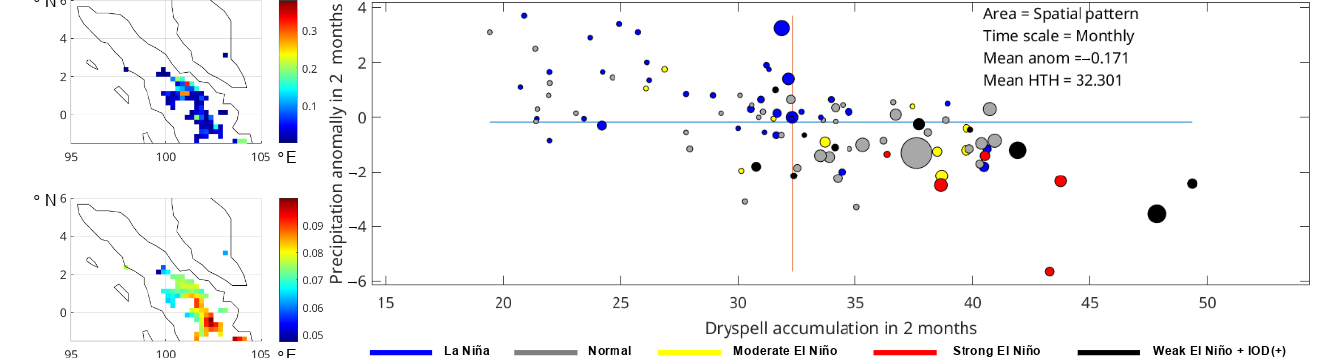
Figure 7. Mid-year dry season of northern Sumatra—spatial graph of hotspots (top) and dry spells (bottom) as well as bubble plot of the monthly fire events for all categories. Blue and orange lines represent average value of respective variables. Size of the bubble represents the number of hotspots for each particular month. Extracted from first mode of SVD with 90.2% of SCF value.